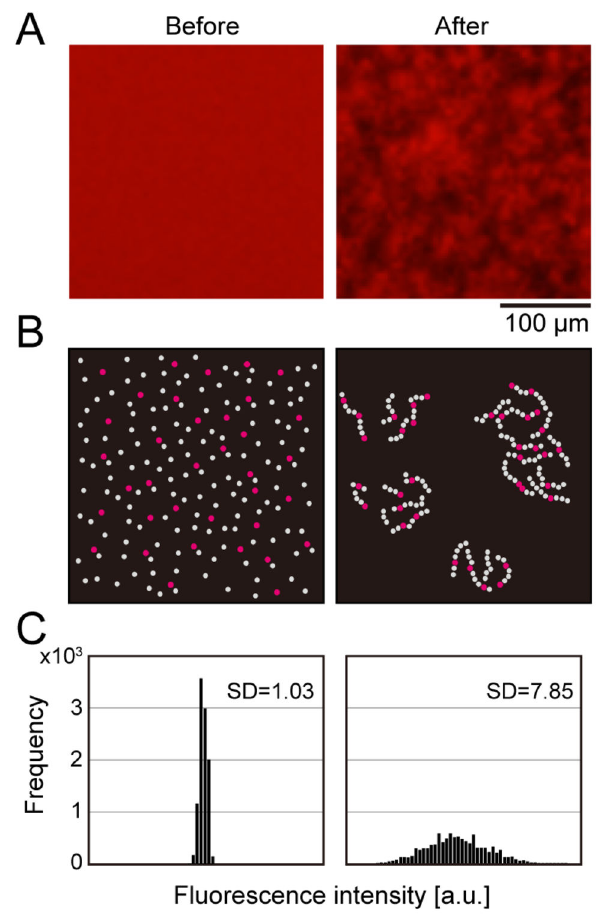
Figure 3. Correlation between Aβ aggregation and variations of fluorescence intensity. (A) Magnified images of center region (100 × 100 pixel) in fluorescence micrographs of QDAβ- Aβ coaggregates before (left) and after (right) 42 incubation (Figure 1B). (B) Schematic illustrations of the distribution of QDAβ (red) and Aβ (gray) molecules before 42 (left) and after (right) incubation of samples. QDAβ molecules are diffused in the sample solution before incubation (left), and QDAβ molecules are inserted in Aβ fibrils after incubation 42 (right). (C) The histograms of fluorescence intensities of 10,000 pixels (100 × 100 pixel) before (left) and after (right) incubation of samples. doi: